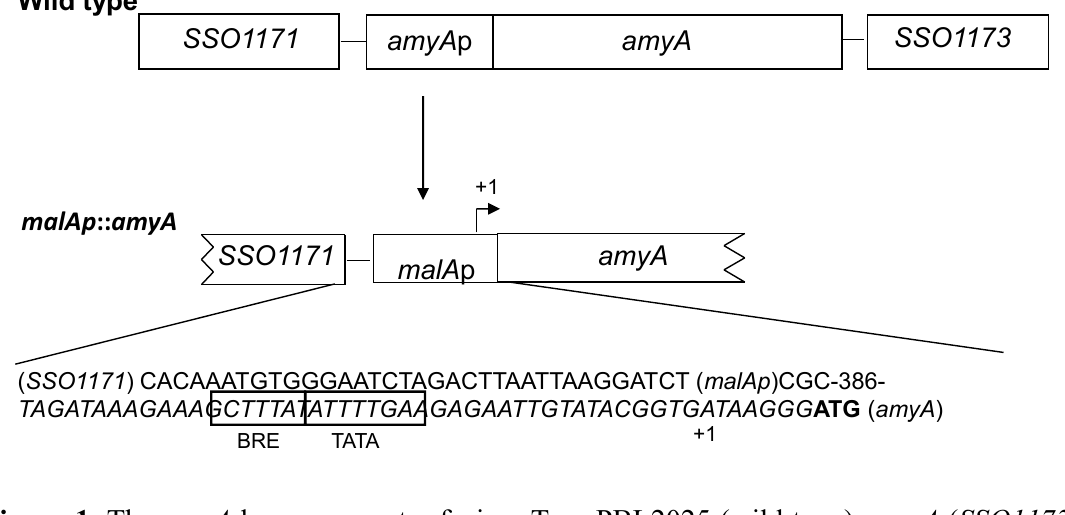
Figure 1. The amyA locus, promoter fusion. Top, PBL2025 (wild type), amyA ( SSO1172 ) and flanking ORFs. Bottom, PBL2058 ( malAp :: amyA ) promoter substitution using malAp . DNA sequence of fusion junctions for SSO1171 :: malAp and malAp :: amyA are shown. The malAp promoter elements (BRE, TATA) are boxed, malAp transcription start is indicated (+1), amyA start codon is shown in